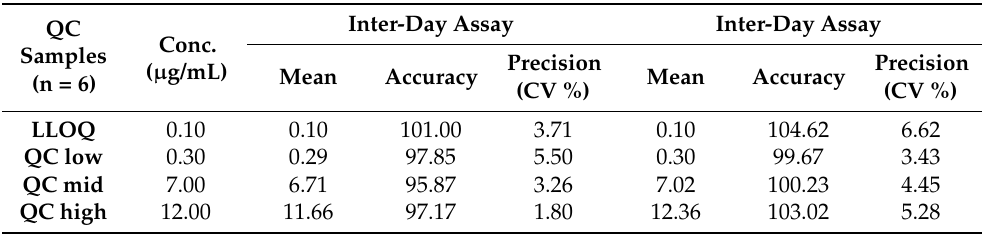
Table 3. Intra- and inter-day accuracy and precision of the RP-HPLC method for the determination of asenapine maleate in dissolution media.